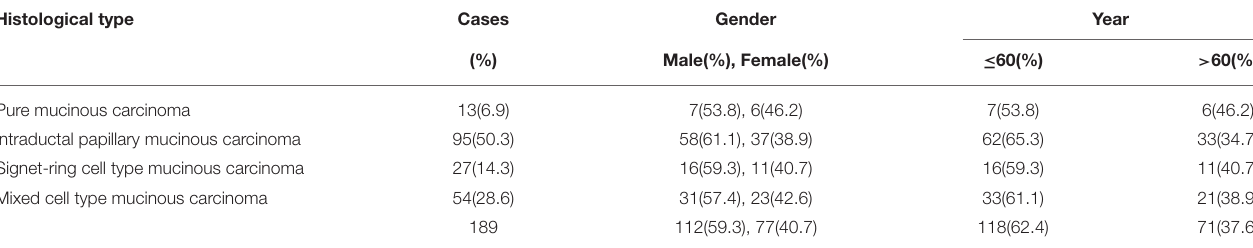
TABLE 1 | Onset age of gastric adenocarcinoma with mucinous differentiation. Histological